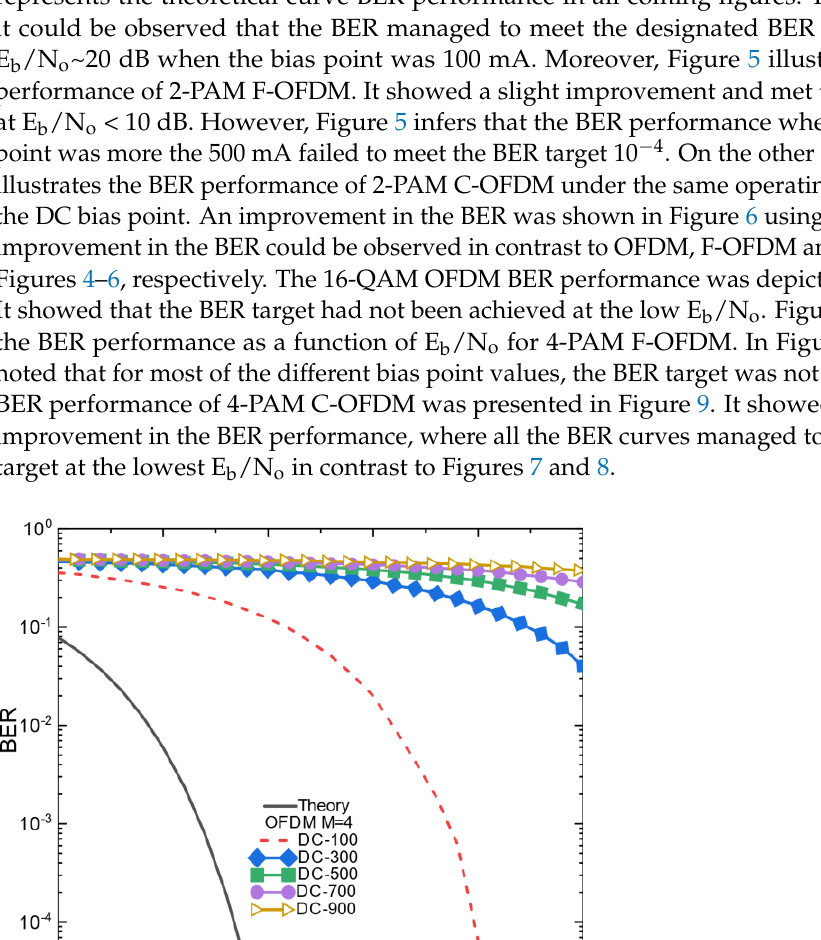
b /N o for OFDM with 4-QAM and 200